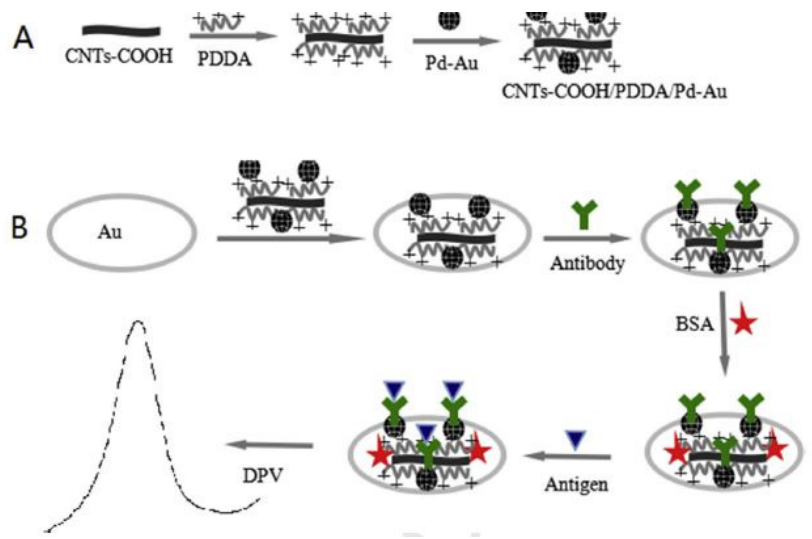
Figure 2. Schematic diagram of the fabrication process of the MWCNTs/PDDA/Pu–Au nanocom- posite-based electrochemical immunosensor [105]. ( A ) first part of process, ( B ) second part of